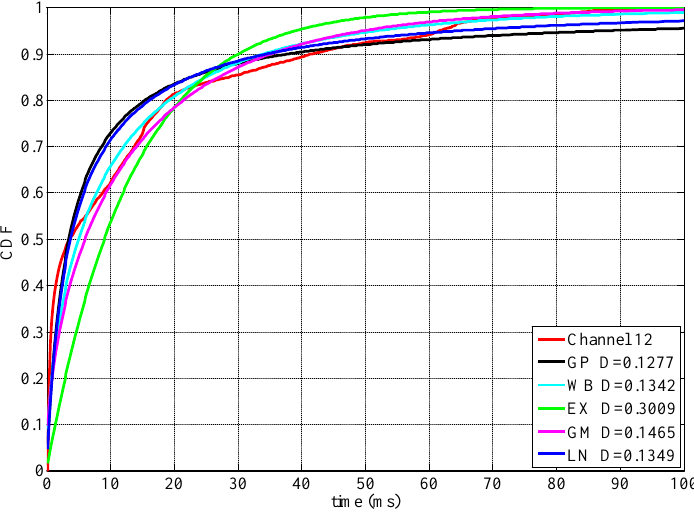
Figure 7. Empirical CDF versus fitted distribution of channel ‘12’.